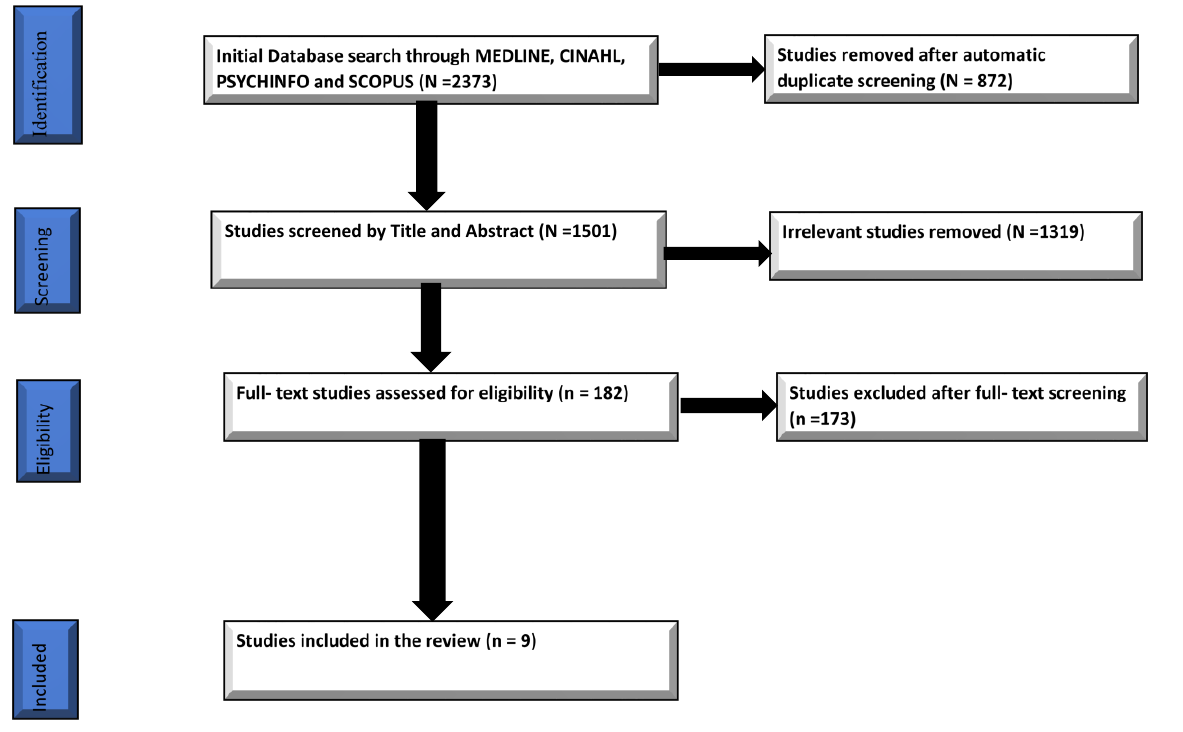
Figure 1. PRISMA — flow diagram summarizing search process and results. Figure 1. PRISMA—flow diagram summarizing search process and